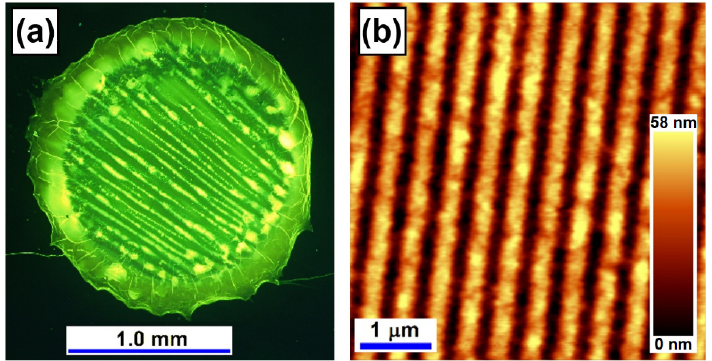
Figure 4. ( a ) Optical microscopic image of the cross ‐ linked F8BT film after the liftoff process by rinsing the sample with chloroform. ( b ) The AFM image of the grating structures produced by direct interference cross ‐ linking and subsequent liftoff process.